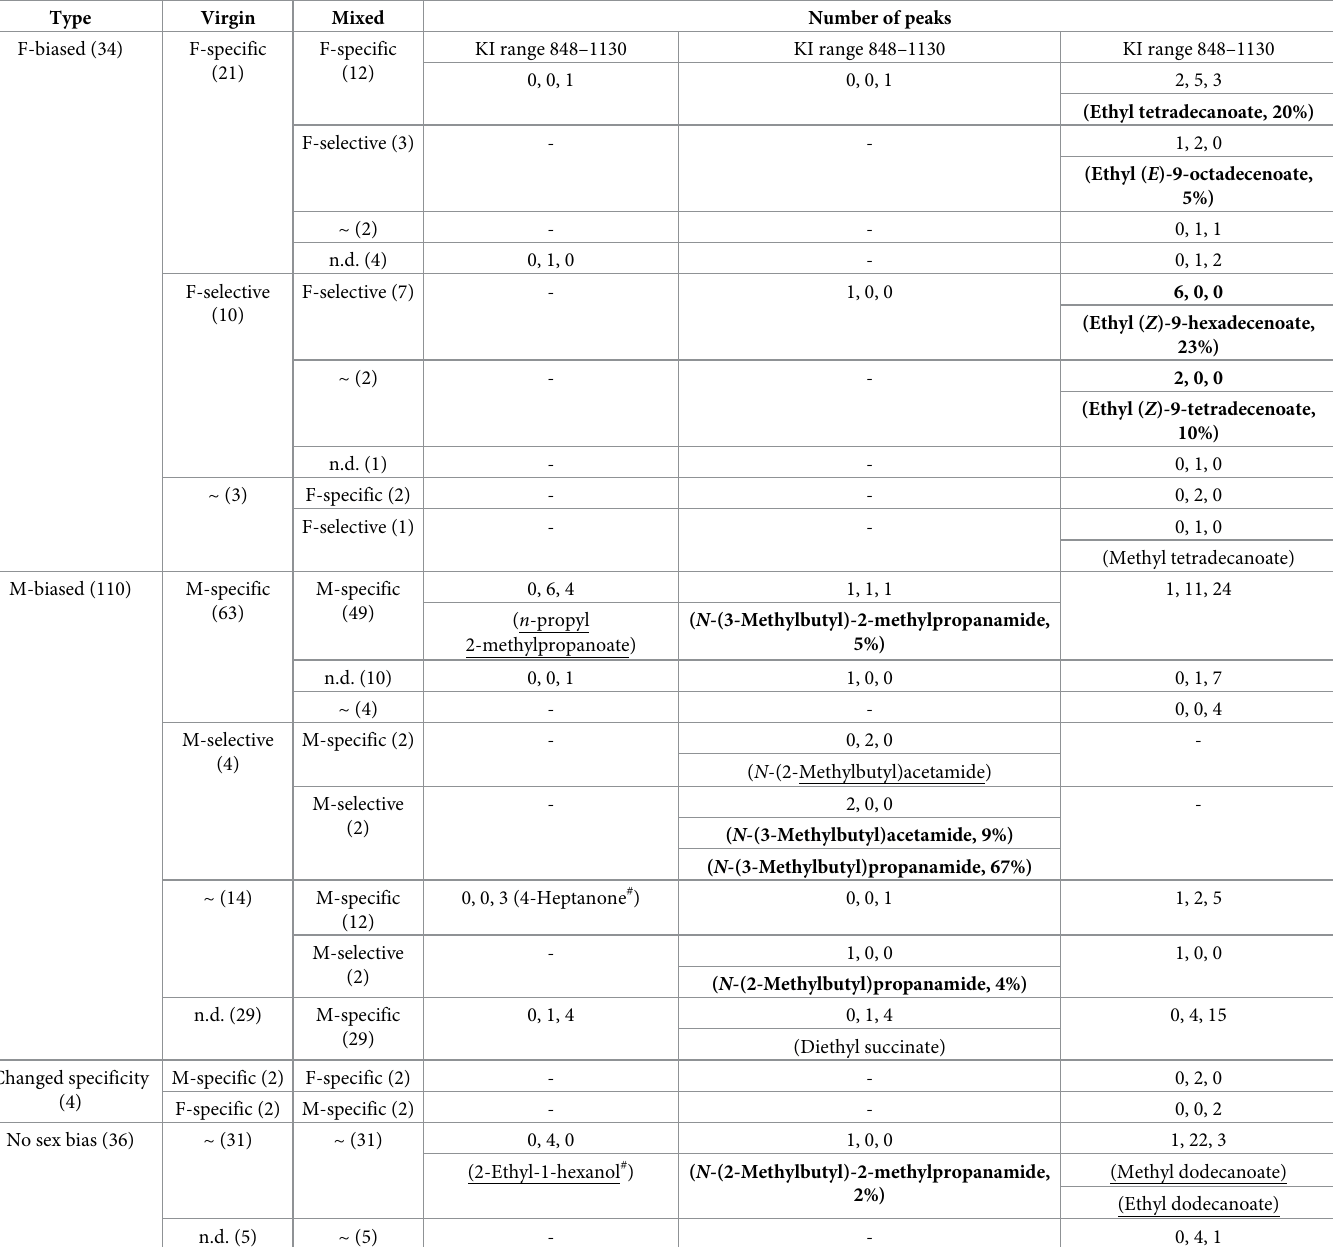
Table 2. Numbers of GC-FID peaks detected classified by sex specificity/ selectivity (F = female, M = male), Rt range and abundance